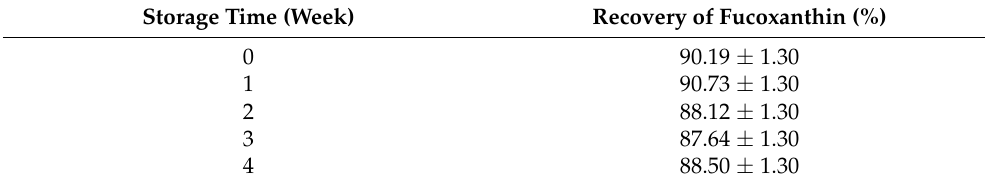
Table 3. Stability of fucoxanthin in yogurt during storage at refrigeration temperature based on (%)